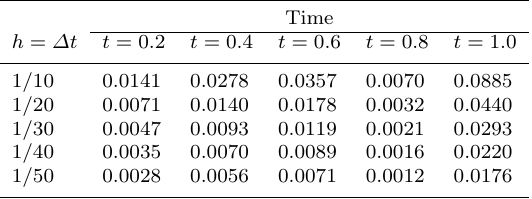
(cid:107) 1 at different h